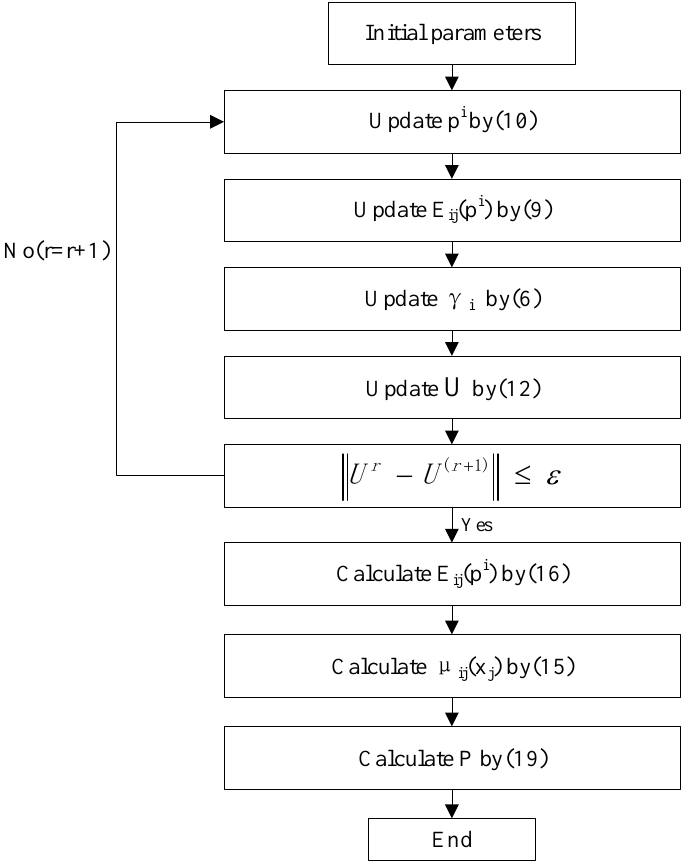
Figure 3. The modified identification procedure of T-S fuzzy model.